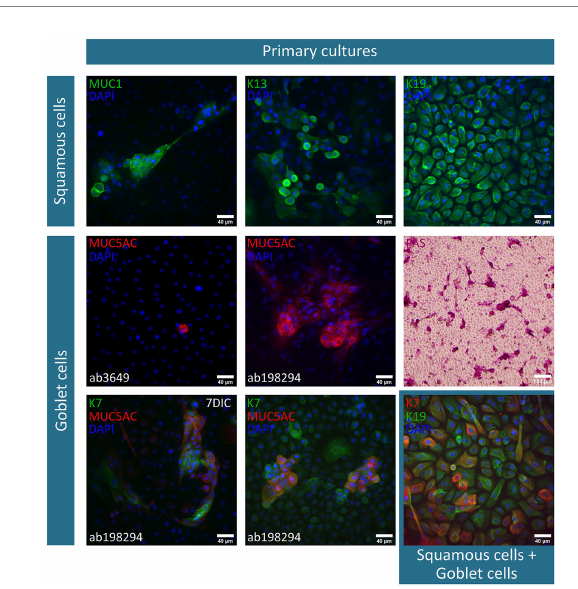
FIGURE 1 Immunofluorescent and periodic-acid-Schiff (PAS)-staining of primary conjunctival explant cultures after a two-week culture period. The investigated markers, along with their corresponding fluorescent label, are summarized per cell type (i.e., squamous epithelial cells and goblet cells) and depicted on each image. Nuclei are counterstained using 4 ′ ,6-diamidino-2-phenylindole (DAPI). Furthermore, deviations on the culture period [i.e., 1 week culture period instead of 14 days in culture (DIC)] or specification on the used mucin (MUC) 5AC antibody are mentioned. K, keratin.